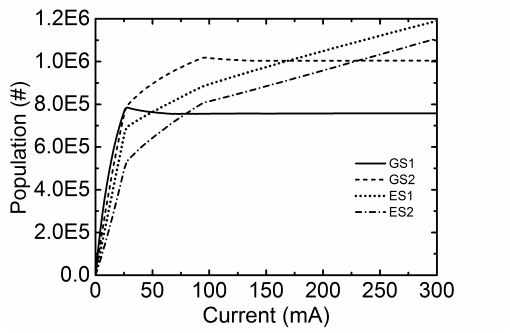
Figure 3. Carrier population versus injection current at excitonic peaks of GS1, GS2, ES1, and ES2